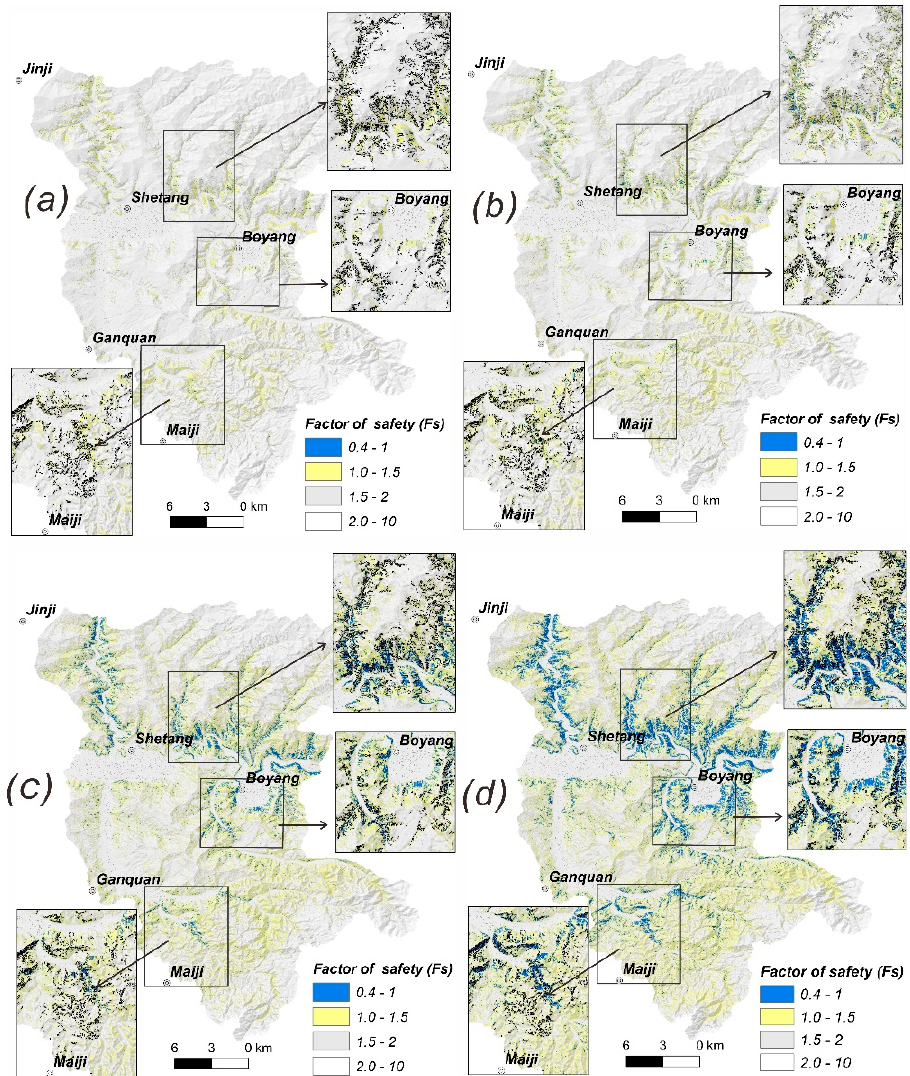
Figure 11. Prediction of the factor of safety (Fs) for shallow slope stability under four rainfall events: ( a ) First rainfall event, from June 19 to 21. ( b ) Second rainfall event, from July 8 to 10. ( c ) Third rainfall event, from July 21 to 22. ( d ) Fourth rainfall event, from July 24 to 25.